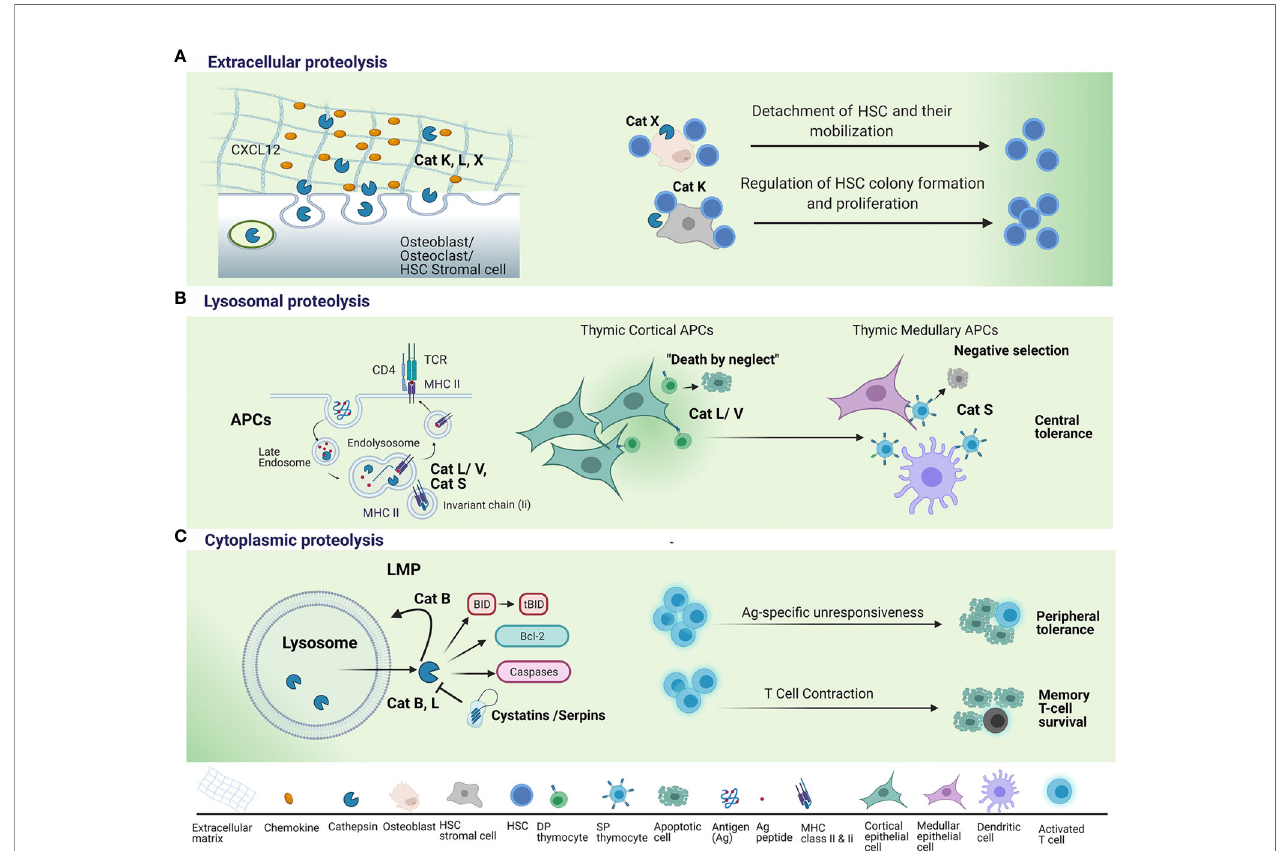
FIGURE 1 | Regulation of T lymphocyte survival by cysteine cathepsins. (A) When secreted into the extracellular space, cysteine cathepsins, such as cathepsin K (Cat K), cathepsin L (Cat L) and cathepsin X (Cat X) remodel extracellular matrix (ECM) and degrade chemokines, such as C-X-C motif chemokine 12 (CXCL12), necessary for hematopoietic stem cells (HSCs) proliferation and their retention within the HSC niche. This leads to detachment of HSCs and their mobilization from the HSC niche. Lack of Cat K within the niche microenvironment results in reduced proliferation of HSC and their cell colony formation and proliferation. (B) Endolysosomal cysteine cathepsins are essential for two steps in major histocompatibility complex (MHC) class II antigen presentation: (a) the degradation of invariant chain (Ii) to class II-associated invariant chain peptide (CLIP) to permit dissociation of CLIP from class II molecules and subsequent peptide binding; and (b) the generation of antigenic peptide fragments from larger polypeptide/protein moieties. Cat L, in mouse cortical thymic antigen presenting cells (APC) and cathepsin V (Cat V) in human APC, have non-redundant roles in degradation of invariant chain (Ii) to class II-associated invariant chain peptide (CLIP). Cathepsin S (Cat S) is involved in MHC class II antigen presentation in medullary thymic APCs. Thymocyte, whose T-cell receptor (TCR) fails to recognize an antigenic peptide/MHC complex on cortical APCs, fails to receive a survival signal i.e. death by neglect. Thymocytes, whose TCR strongly binds to antigenic peptide/MHC complex on medullary APCs are eliminated i.e. negative selection. (C) Following the induction of apoptosis, lysosomal cathepsins are released from lysosomes through lysosomal membrane permeabilization (LMP). Cathepsins B (Cat B) and L perform their pro-apoptotic function in the cytosol by cleaving Bid, a pro-apoptotic Bcl-2 family member, anti-apoptotic Bcl-2 family protein or cleaving and directly activating caspases. Cysteine peptidase inhibitors, such as serpins and cystatins, may regulate cathepsin activity in the cytosol. Cat B further promotes LMP and the release of lysosomal constituents. Cathepsins B and L released through LMP have been implicated in apoptosis triggered by supraoptimal activation of T lymphocytes i.e. high dose tolerance. Cat B pro-apoptotic actions in the cytosol have been shown to mediate apoptosis induction upon critical phase of immunity whereby the vast majority of effector T cells die by apoptosis i.e. T cell contraction. Upregulation of endogenous inhibitor (Spi) 2A enables survival of memory T cells; antigen